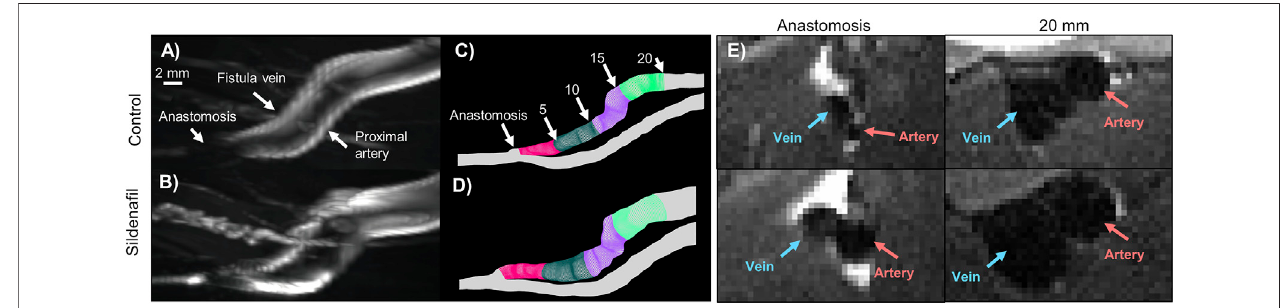
FIGURE2| MRIimagesandlumengeometricalmodelsoffemoralAVFforcontrolandsildena fi ltreatedrats. (A,B) MaximumintensityprojectionoffemoralAVFina control rat (A) and a sildena fi l treated rat (B) . (C,D) Lumen geometry reconstruction ofAVF in a control rat (C) and a sildena fi l treated rat (D), with 0 – 5 mm zone shown in magenta,5 – 10 mmzoneshownindarkgreen,10 – 15 mmzoneinpurple,and15 – 20 mmzoneinlightgreen. (E) Black-bloodMRIimagesoftheanastomosisandaslice 20 mm away from the anastomosis for control and sildena fi l treated rats. Red and blue arrows point to the artery and vein, respectively.